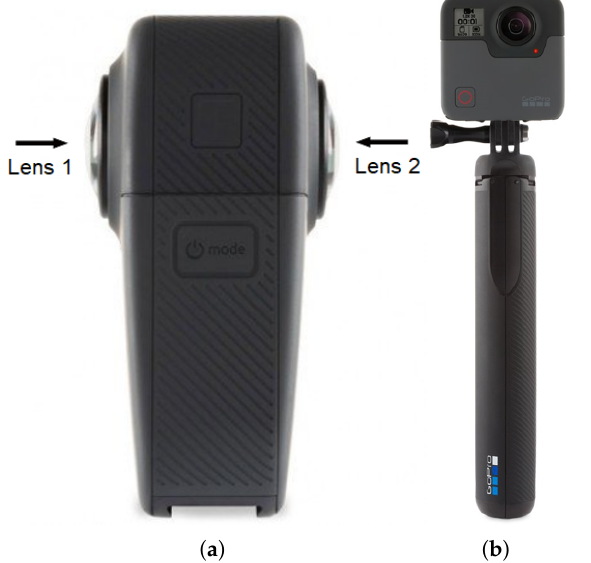
Figure 3. GoPro Fusion camera. ( a ) Side view and ( b ) front view with extensible grip attached.